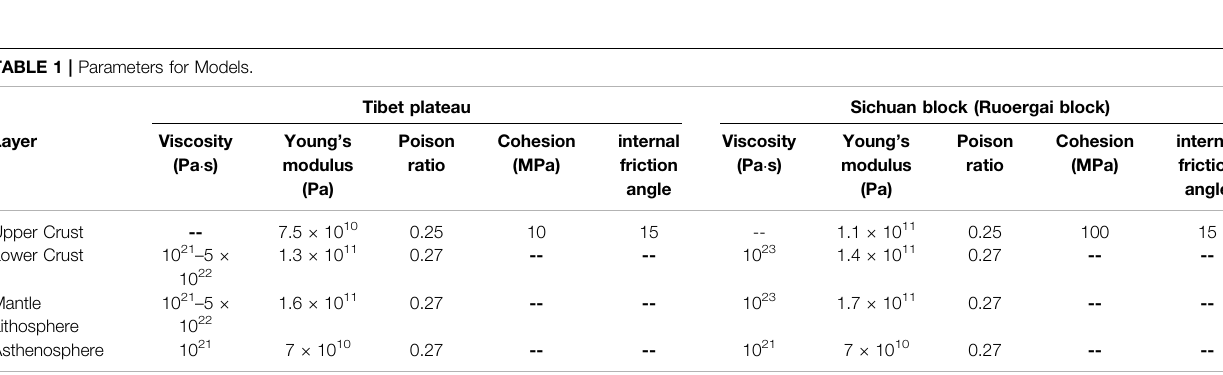
TABLE 1 | Parameters for